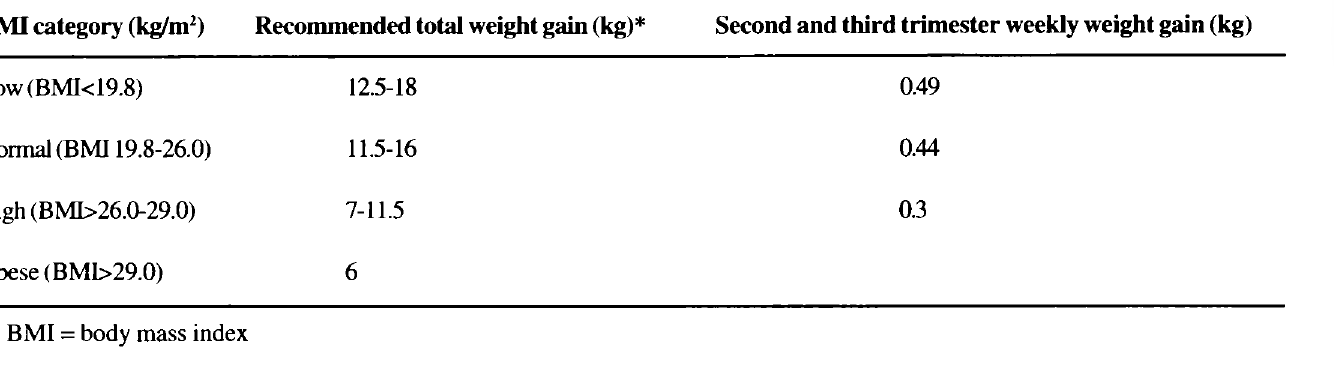
Table 1 Recommended total weight gain during pregnancy by pre-pregnancy